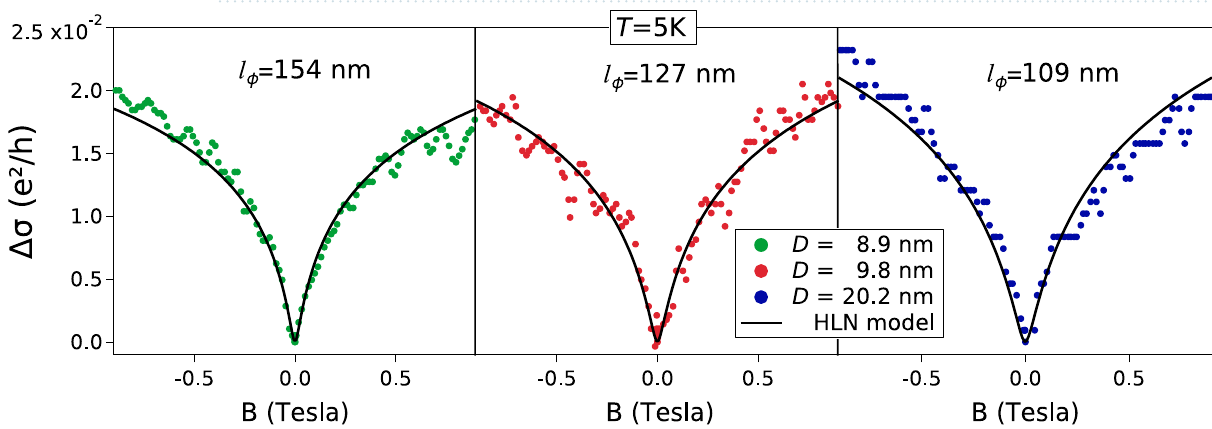
Figure 9. Magnetoconductance curves at 5 K as a function of the applied magnetic field B. The solid lines represent the fitted curves using the HLN model (Ref. 12 ), Eq. (1). For the fitted curves we obtained l φ = 154 nm, 127 nm, 109 nm and α = − 511, -604, -747 for the samples S1, S2 and S3,